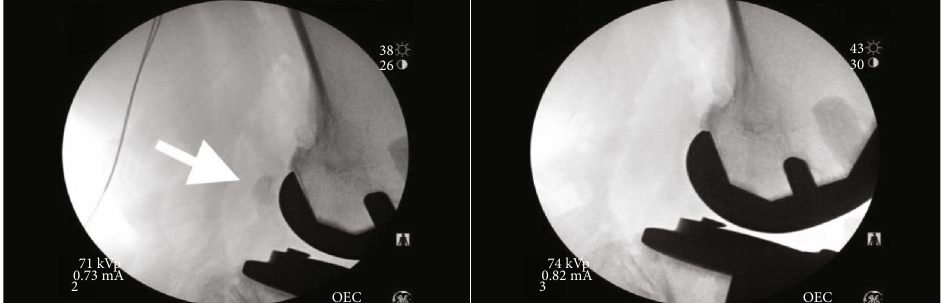
Figure 1: Intraoperative fl uoroscopy. (a) Fabella before excision. (b) Knee after excision.